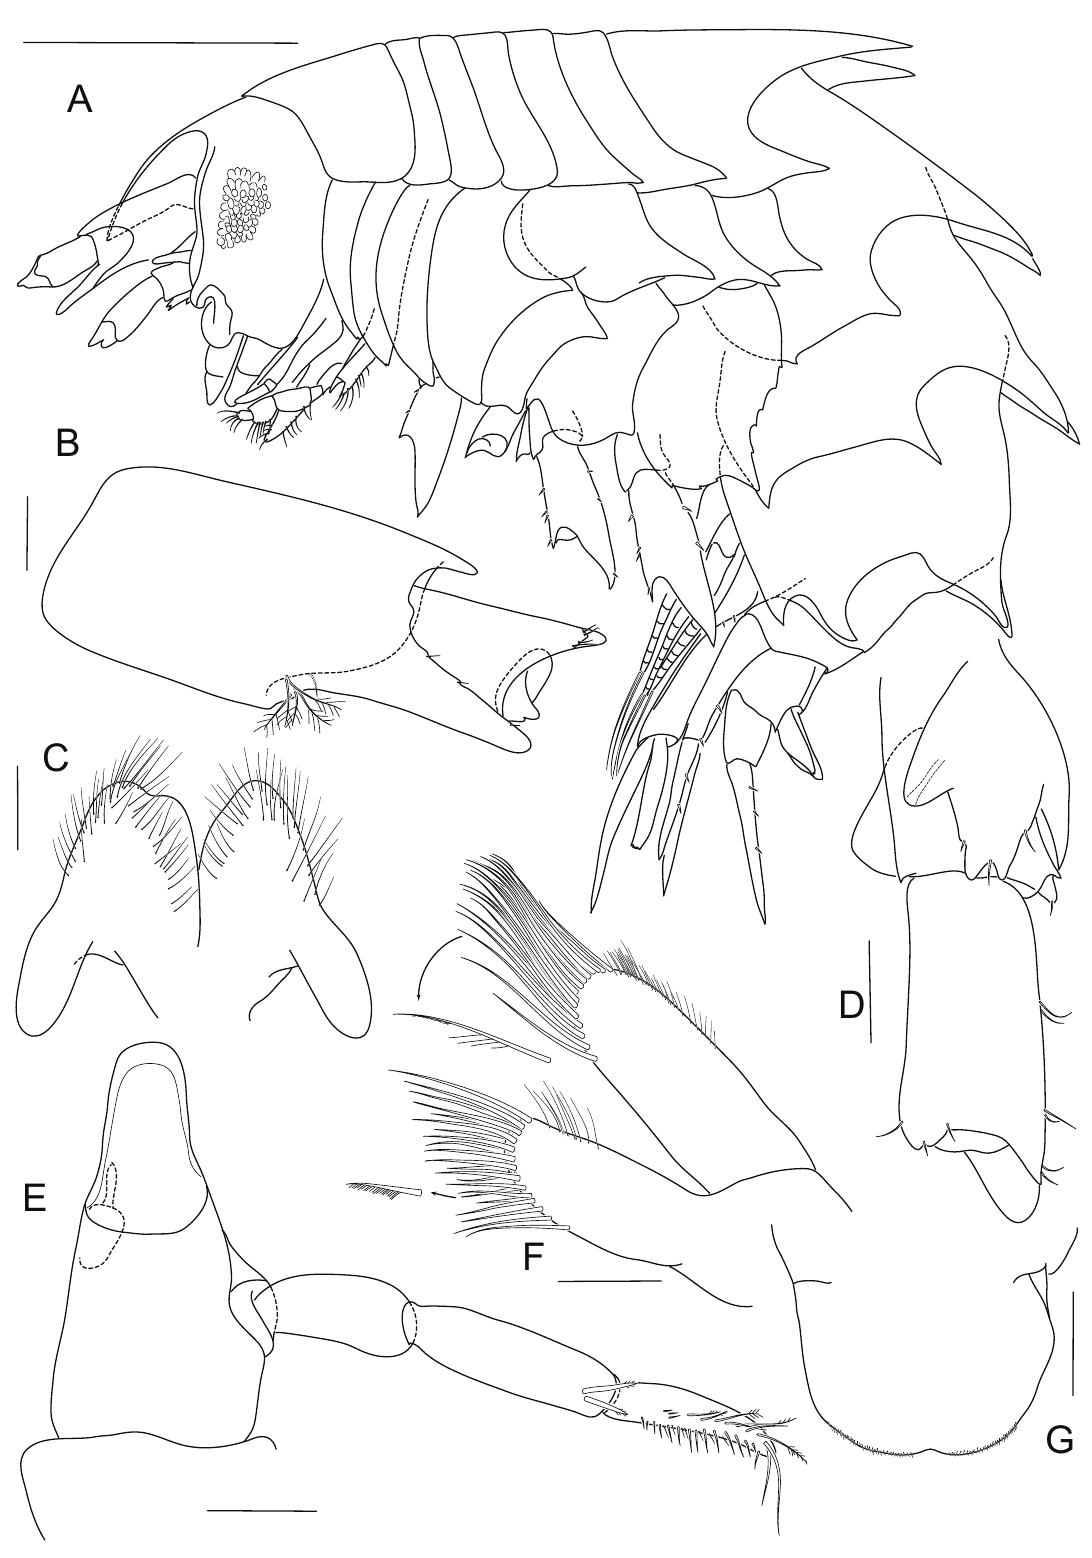
Fig. 2. Labriphimedia meikae nov. sp., holotype ♂, 6 mm, NIWA 84598. A . Habitus. B . antenna 1, peduncular articles 1-2. C . lower lip. D . antenna 2, peduncular articles 1-4. E . left mandible. F . maxilla 2. G . Upper lip. Scale bars: a = 1 mm, B-G = 100